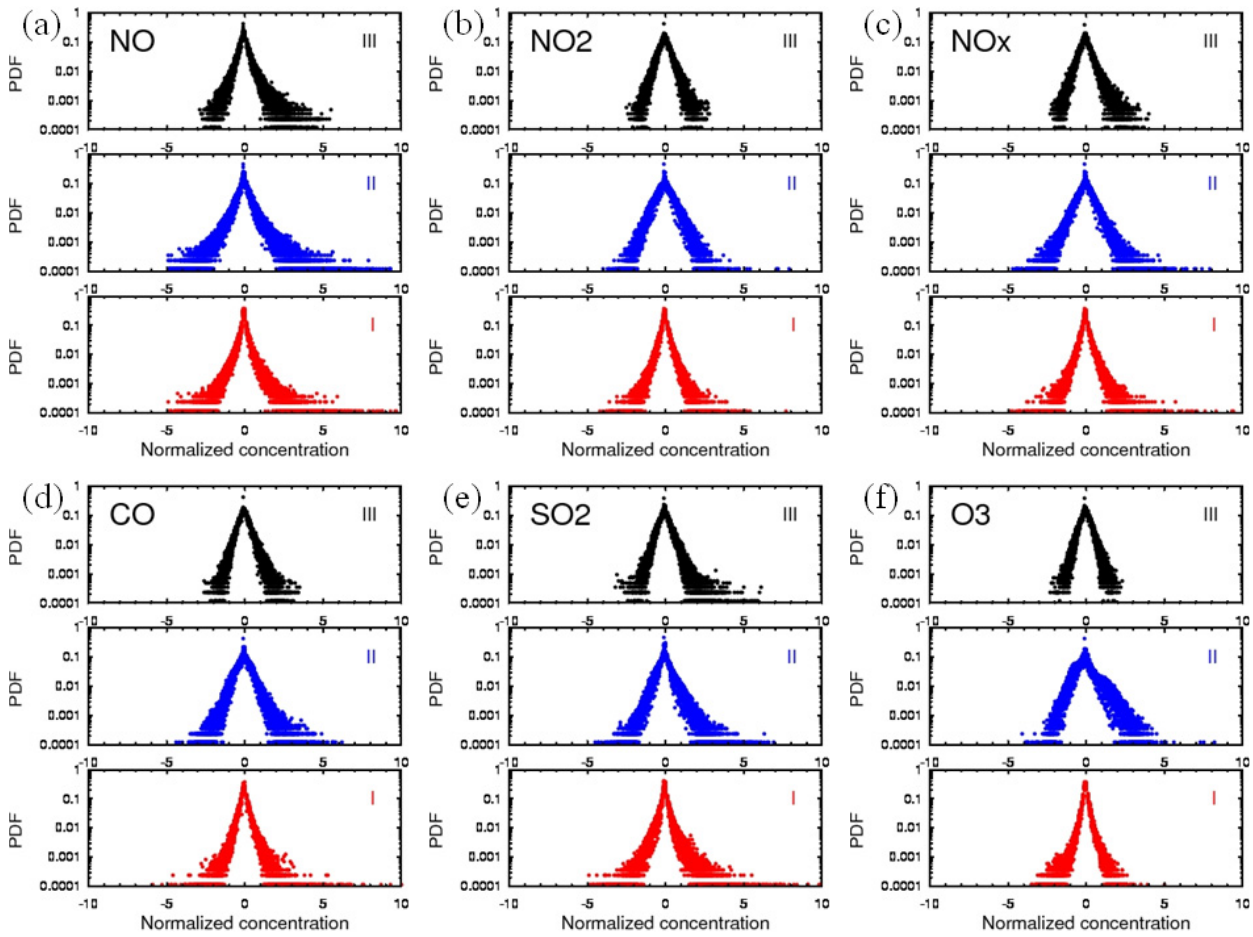
Fig. 9. The PDFs for the gases, NO (panel a ), NO 2 (panel b ), NO x (panel c ), CO (panel d ), SO 2 (panel e ), and O 3 (panel f ) plotted in the semi-log scale. For each gas, the black, blue, and red dots are for reconstructed time series in the frequency bands III, II and I, respectively. The sum of the frequencies in regions I, II and III is the same as those in the region V shown in Fig.